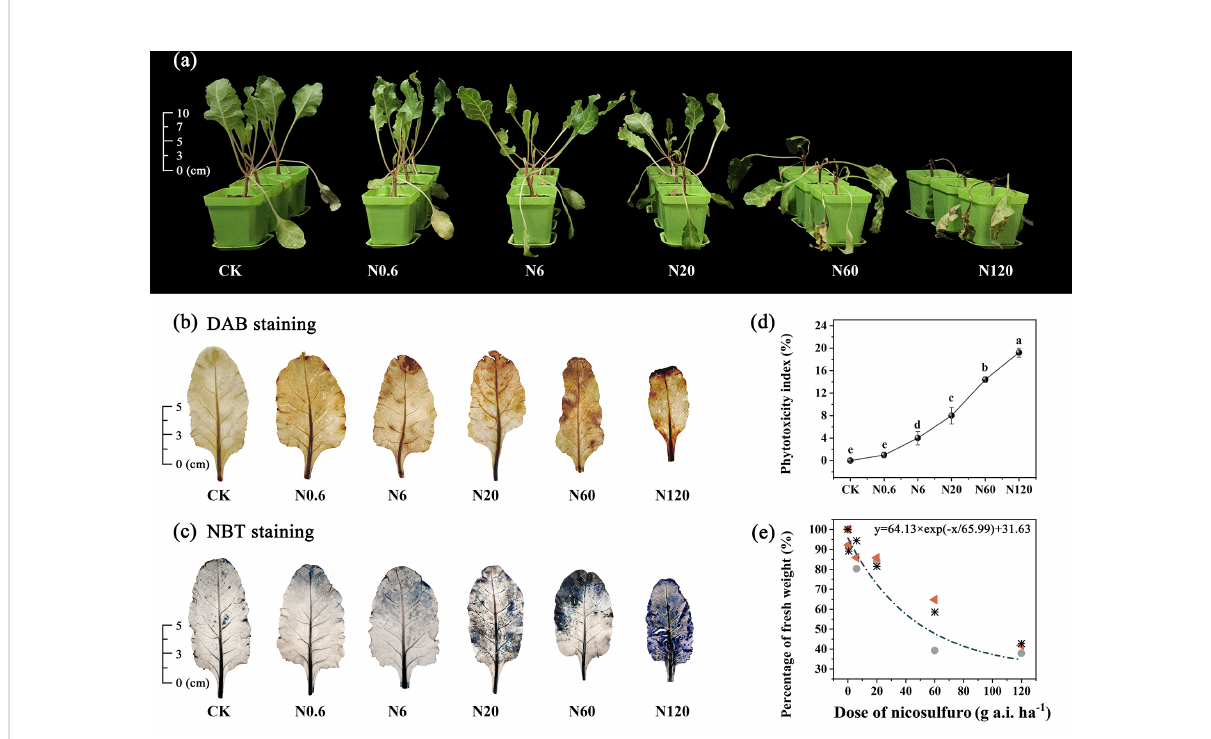
FIGURE 1 Effects of nicosulfuron on visible symptoms of phytotoxicity on sugar beet. The growth of sugar beet (A) , DAB staining (B) , NBT staining (C) , phytotoxicity index (D) , and dose-fresh weight response curve (E) in sugar beet on 20 DAT with different doses of nicosulfuron. Triangles, circles and asterisks represent different repetitions. Data with the different letters indicate signi fi cant differences between different doses of nicosulfuron drift (n = 6, p <